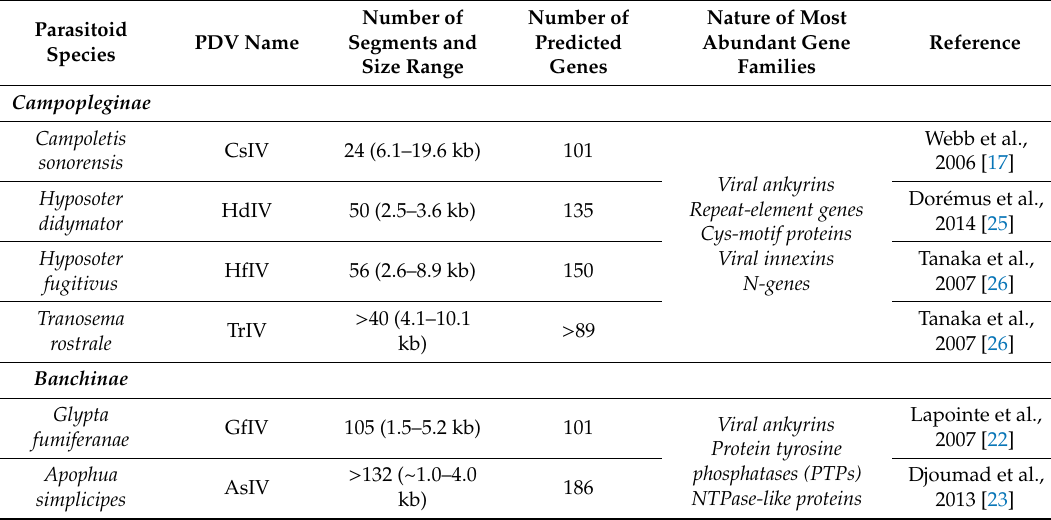
Figure 2. Morphological differences between virus particles found in ichneumonid wasps. Upper panel. Transmission electron micrographs of female oviduct transversal sections; particles shown are observed in the calyx lumen for campoplegine IVs (typical and Bathyplectes types) and Venturia canescens VLPs; particles are shown in the nucleus of calyx cells for banchine IVs. Lower panel. Schematic representation of the secreted particles. cyt, cytoplasm; env., particle envelopes, NC, nucleocapsid. Table 1. Features of the sequenced packaged ichnovirus genomes from campoplegine and banchine ichneumonid species.